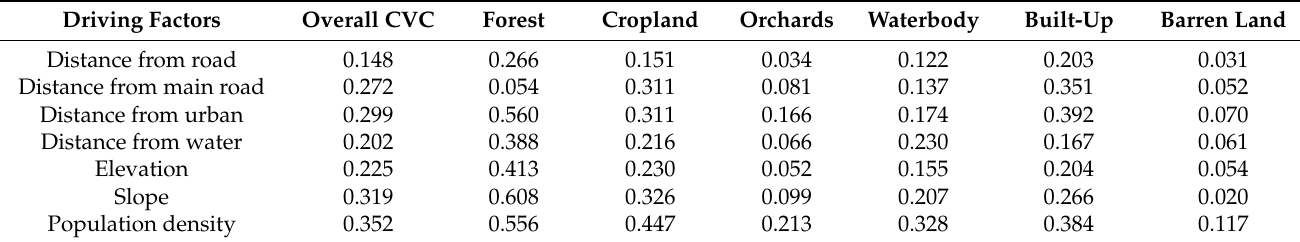
Table 10. Cramer’s correlation analysis of the seven driving factors